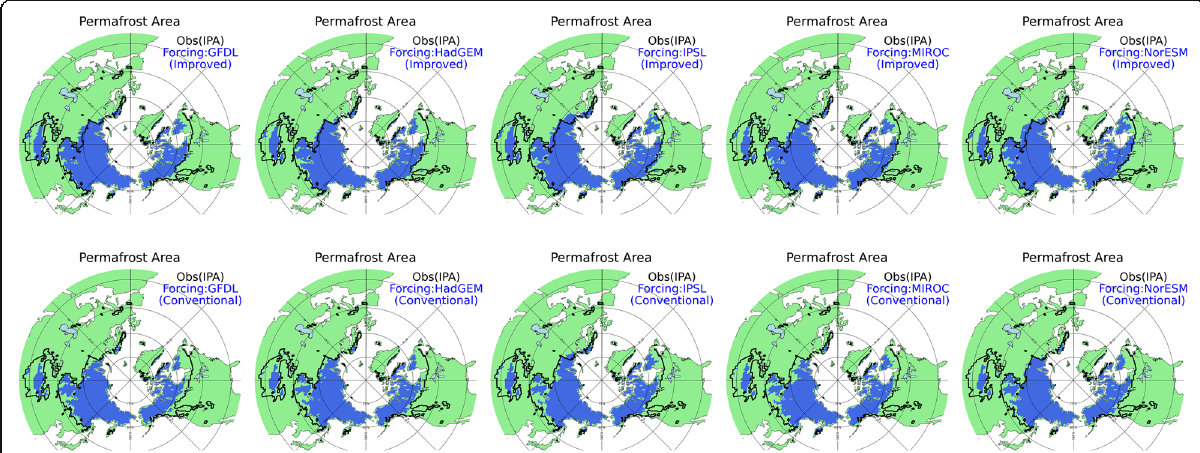
Fig. 4 Permafrost area of the historical model simulation (blue) and observation (outlined in black) for the simulations with the atmospheric forcings of all five GCMs (GFDL-ES2M, Dunne et al. 2012; HadGEM2-ES, Jones et al. 2011; IPSL-CM5A-LR, Dufresne et al. 2013; Nor-ESM, Bentsen et al. 2013; MIROC-ESM-CHEM, Watanabe et al. 2011). The upper panel shows the results with the improved scheme; the lower panel shows the